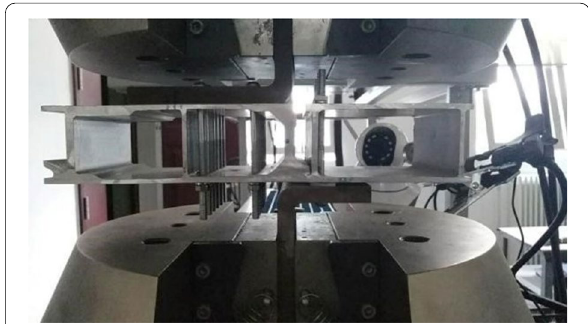
Figure 19 Bending fatigue test of 6005 aluminum alloy FSW joint